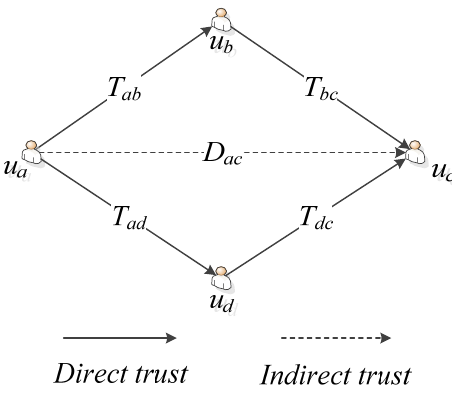
Figure 1. A trust relation sample.